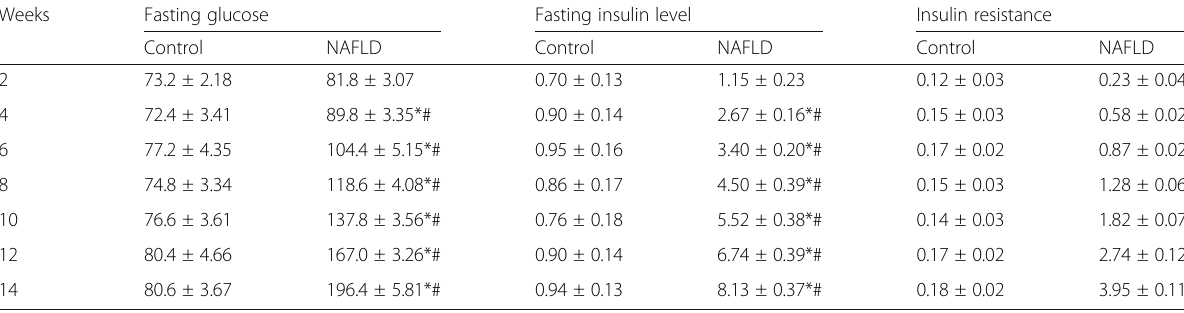
Table 4 The glucose homeostasis parameters of control and NAFLD groups Weeks Fasting